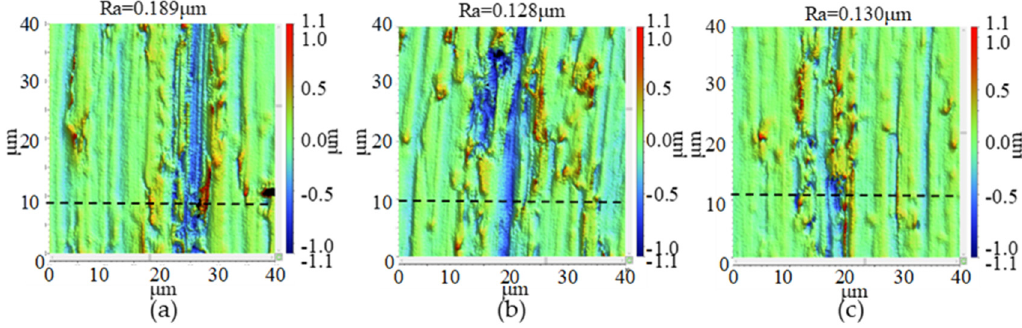
Figure 3. The surface morphology of the milled aluminum workpiece with different milling distance.